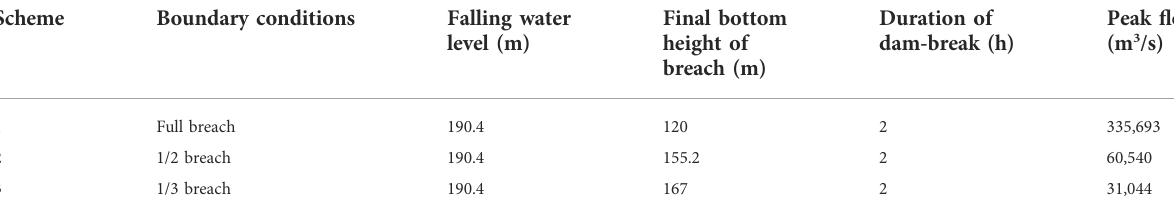
TABLE 2 Basic information sheet of each program.